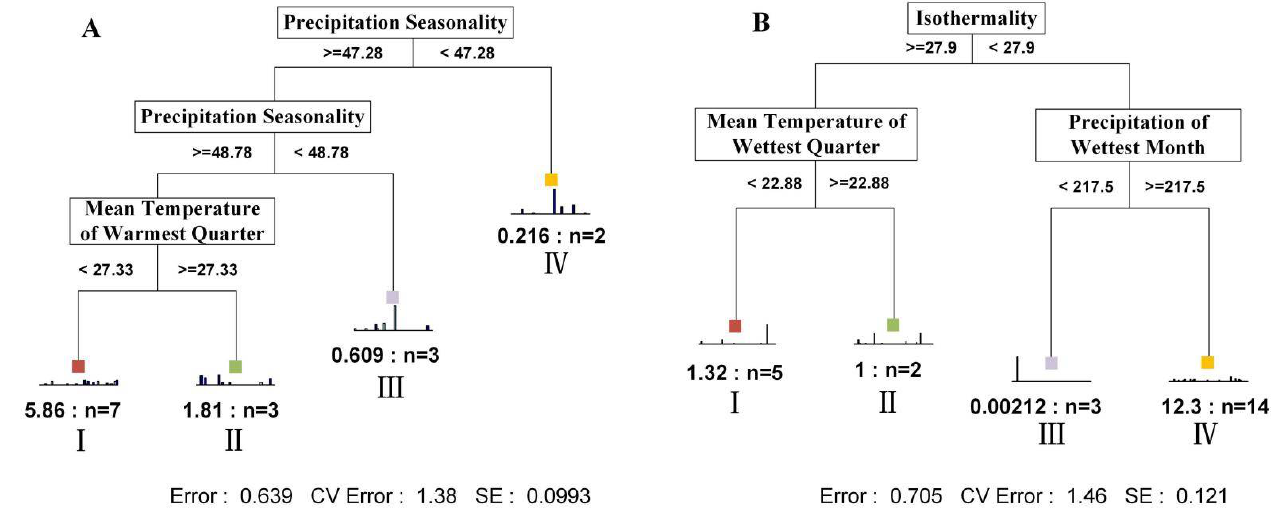
Figure 6. Multiple regression tree for classification of artificial disturbance ( A ) and natural community ( B ). community ( B